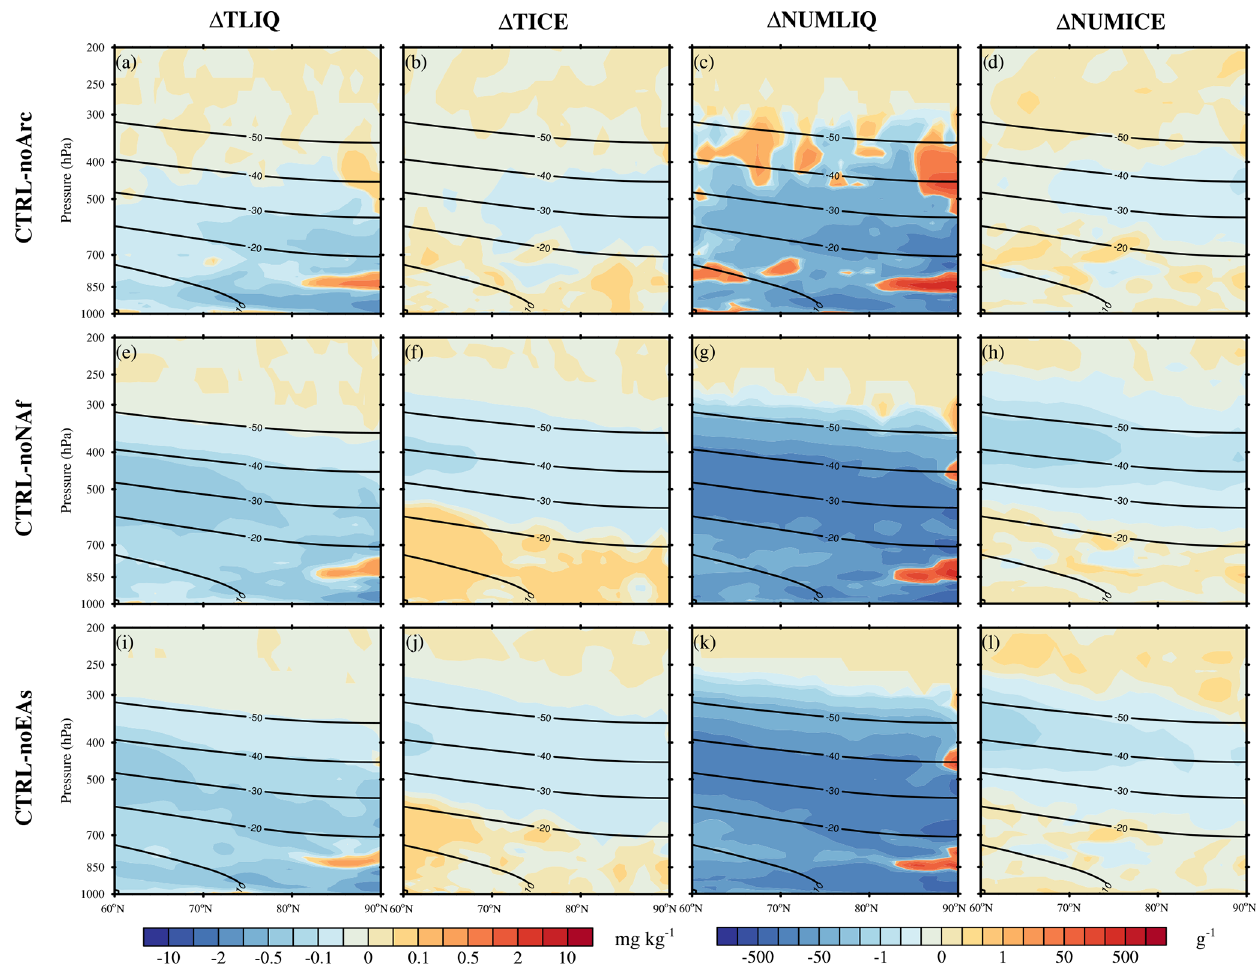
Figure 11. Annual and zonal mean differences (year 2007 to 2011) in total liquid water mass mixing ratio (TLIQ), total ice mixing ratio (TICE), cloud droplet number concentration (NUMLIQ), and cloud ice number concentration (NUMICE) in the Arctic. Black contours are zonally averaged temperatures ( ◦ C). Top, middle, and bottom panels show the differences between CTRL and noArc, noNAf, and noEAs, respectively.